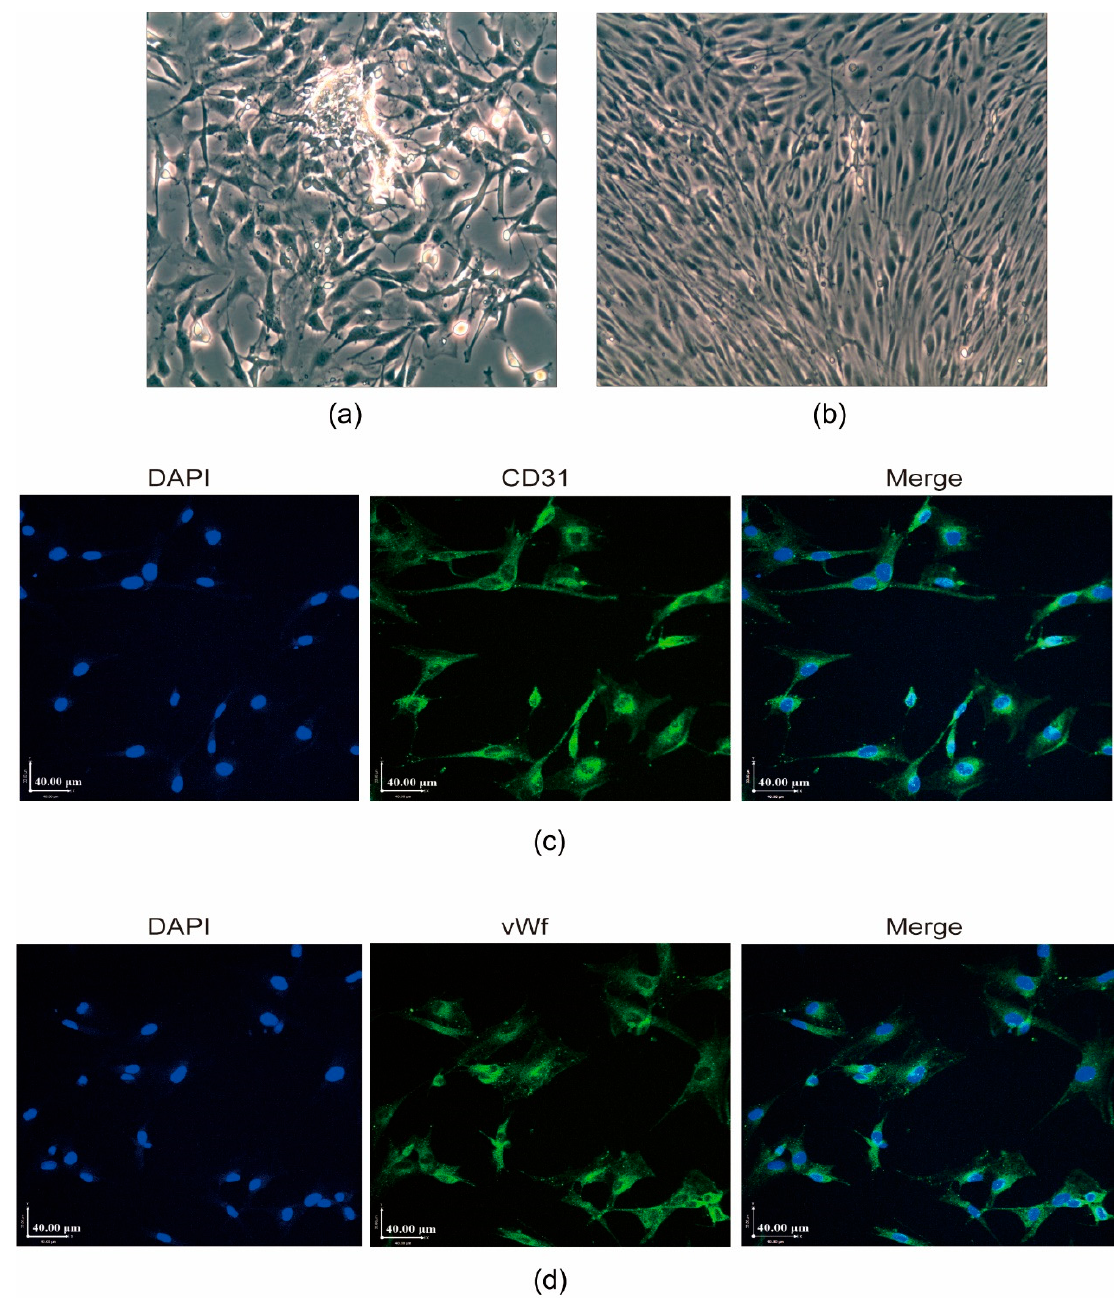
Figure 1. Characterization of established rat retinal capillary endothelial cell (RCEC) cultures. ( a ) Endothelial cells migrated from the retinal capillary fragments after 5 d. ( b ) Cells acquired a typical contact-inhibited monolayer with a short fusiform or round morphology after 8 to 10 d. The original magnification was 200 × . ( c ) and ( d ) The RCECs were analyzed for the expression and localization of endothelial cell markers by immunofluorescence staining of CD31 and the von Willebrand factor (vWf). All nuclei were stained with 4 ′ ,6-diamidino-2-phenylindole (DAPI) (blue fluorescence). Scale bar: 40 μ m.